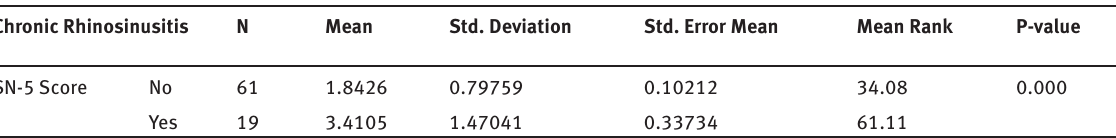
Table 1: Comparison of mean SN-5 in patients with chronic rhinosinusitis and those non-chronic rhinosinusitis in patients with cystic fibrosis referred to The Masih Daneshvari hospital from 2017–2018.